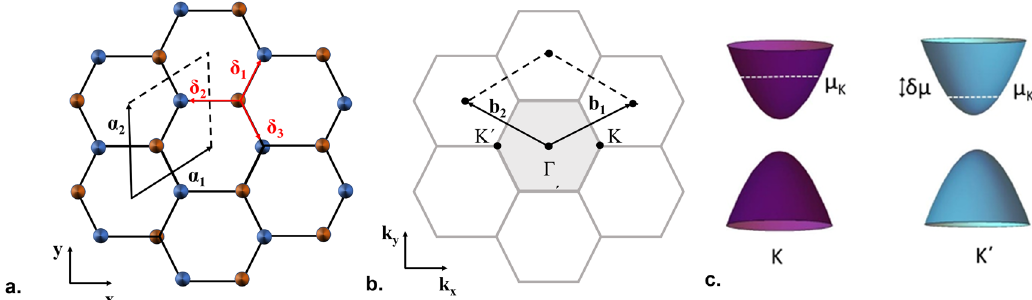
Fig. 1 Crystal structure, Brillouin zone, and dispersion of monolayer transition metal dichalcogenides. a Top view of monolayer TMD honeycomb lattice with transition metal atoms in red and chalcogen atoms in blue. The lattice vectors a 1 and a 2 and fi rst-neighbor vectors δ 1 , δ δ 2 , and 3 are also shown. The region bounded by dashed lines corresponds to the primitive cell. b First Billouin zone (shaded) of monolayer TMD showing the high symmetry points Γ , K, and K ′ . The reciprocal lattice vectors b 1 and b 2 are also depicted. c Schematic of monolayer TMD dispersion. The paraboloids represent valence and conduction bands at K (purple) and K ′ (cyan) points. The white dashed lines indicate the chemical potential at different valleys for the case of population